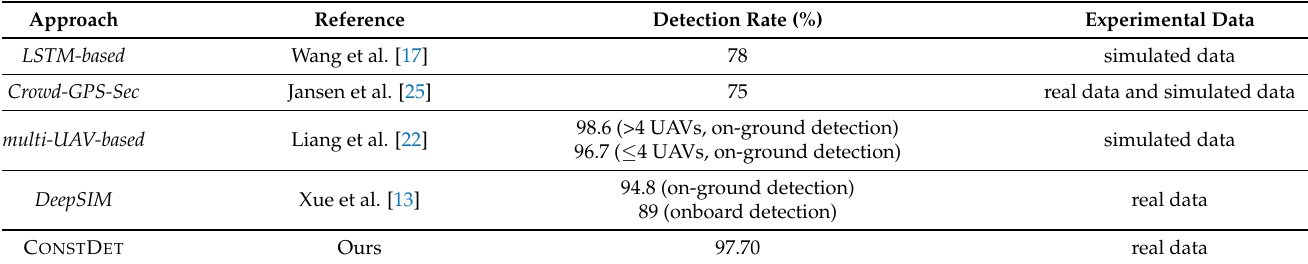
Table 8. Comparison of the performance of C ONST D ET and those of existing works. LSTM-based , DeepSIM , and C ONST D ET are ML-based detection approaches. Crowd-GPS-Sec and multi-UAV-based are non-ML-based detection